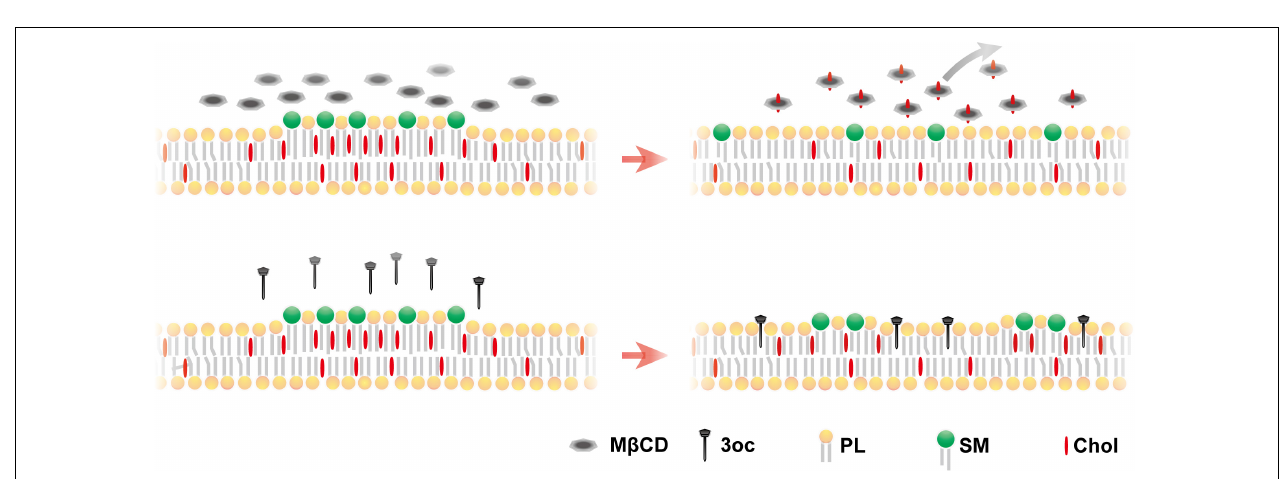
FIGURE 5 | Cell viability of THP-1 cells treated with different concentrations of 3oc. (A) Cell apoptosis was detected by the Annexin V/PI apoptosis detection kit and then measured by flow cytometry, statistical analysis results of three experiments. Live cell% = (Annexin V negative cells in M β CD or 3oc treatment/total cells)/(Annexin V negative cells in DMSO treatment/total cells) × 100%. (B) The Western blot results show that when the 3oc concentration reaches 30 µ M, and it can induce obvious activation of Caspase 3. The values reported under each blot are densitometry analysis relative to controls taken as 1 after normalization by internal reference. All experiments were repeated three times, and the bars represent the mean ± SD ( n = 3); * P < 0.046 as measured by an unpaired t -test.